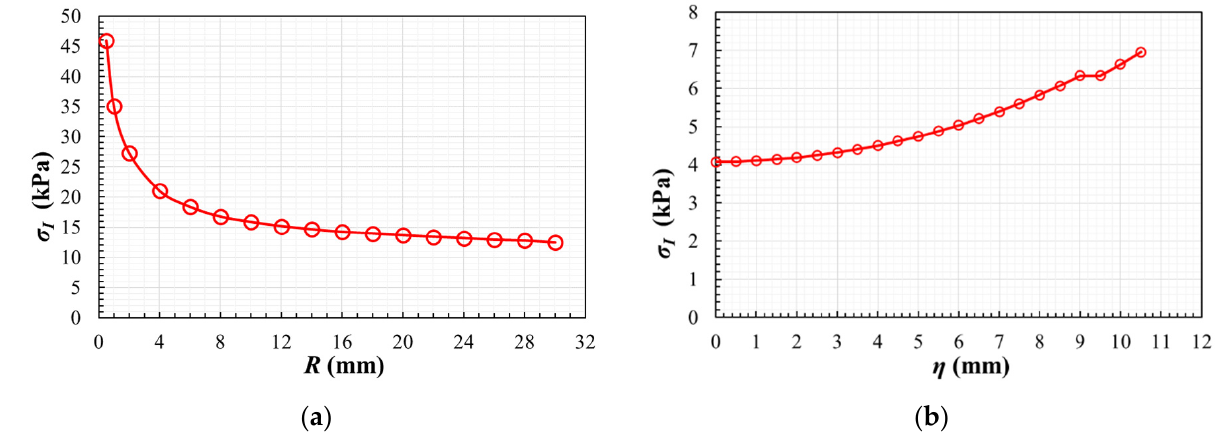
Figure 8. In geometry A: ( a ) the highest value of the maximum principal stress (expressed in absolute value) as a function of the fillet radius; ( b ) maximum principal stress along the path for a fillet radius R = 10 mm.